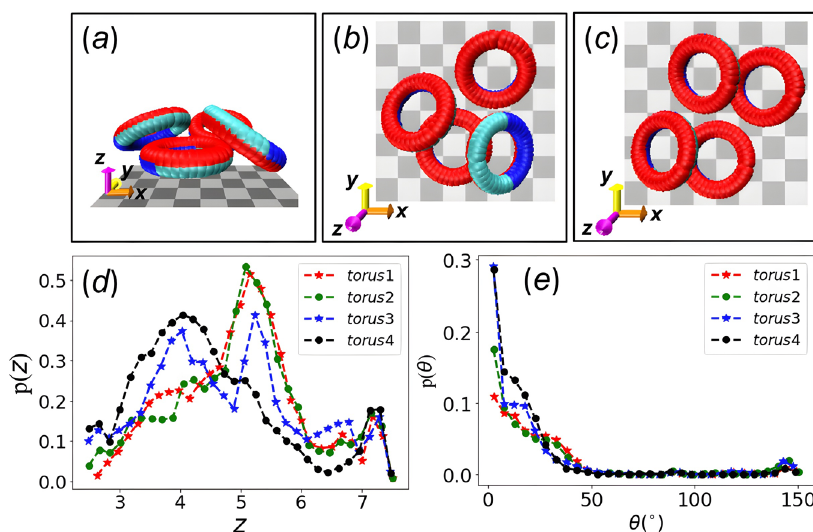
Fig. 7 Bond states of four tori near the wall for g = 0.07,7D2 ϵ cd = 0.2. a – c Instantaneous con fi gurations of metastable bound states of four forward- moving tori near the wall; a and b top and side views at the same time instant, c top view from another realization of the dynamics at a given time instant. d – e P ( z ) and p ( θ ) probability distributions constructed from 25 realizations of the dynamics, the symbols show the mean values. The red colour indicates the catalytic surface. The blue/green facets correspond to the non-catalytic surface. The torus moves with the blue facet forward.